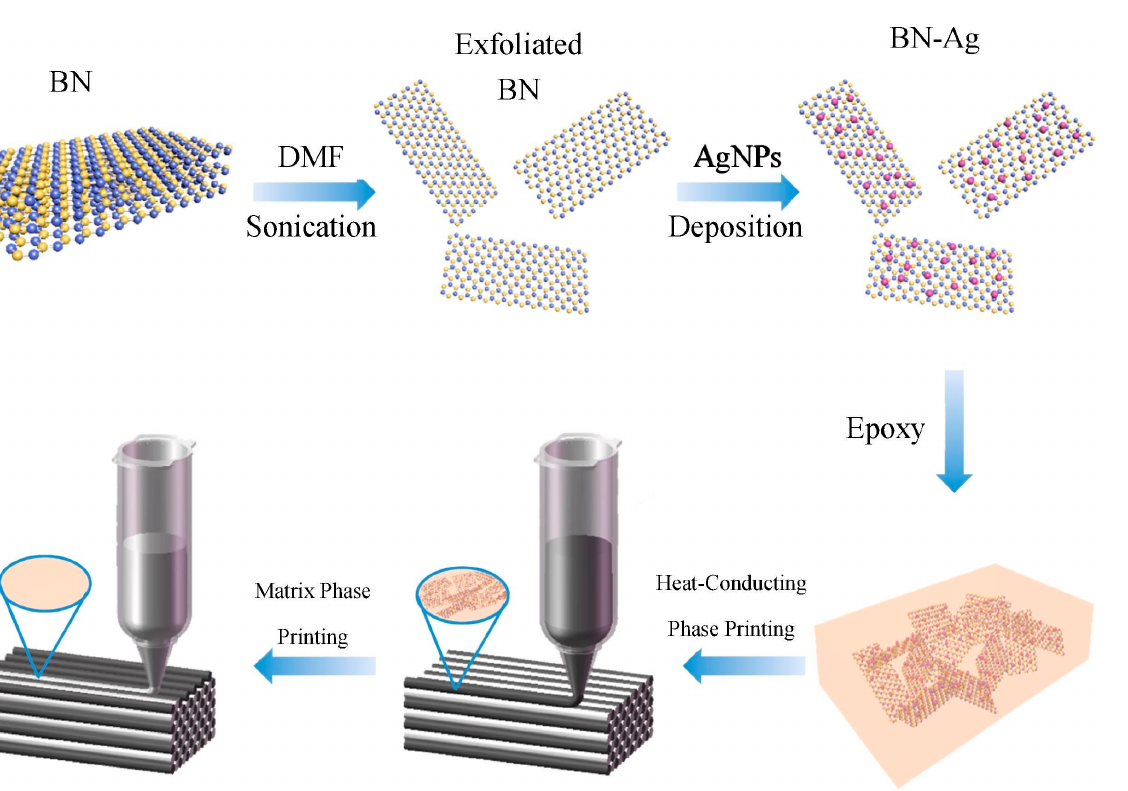
Figure 5. Schematic diagram of the preparation of BN-Ag/epoxy resin composites (reproduced with permission from Reference [37] , Copyright 2020 Elsevier).